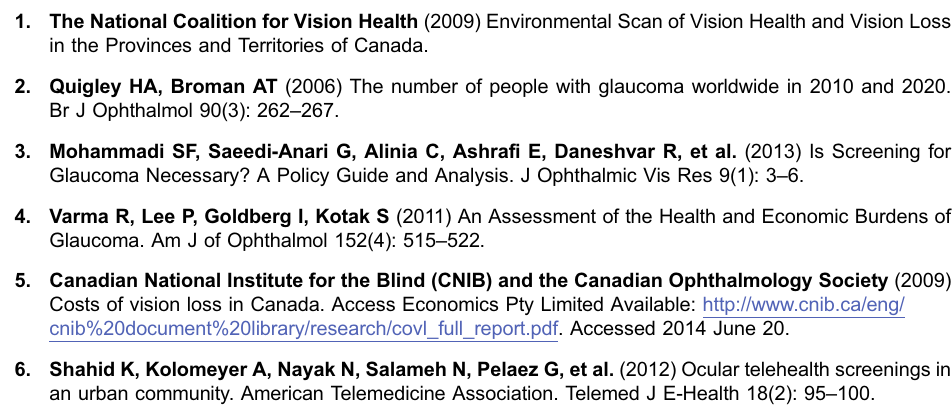
Table S1. Systematic review search strategy. Table S2. PRISMA checklist. Table S3. Excluded full-text